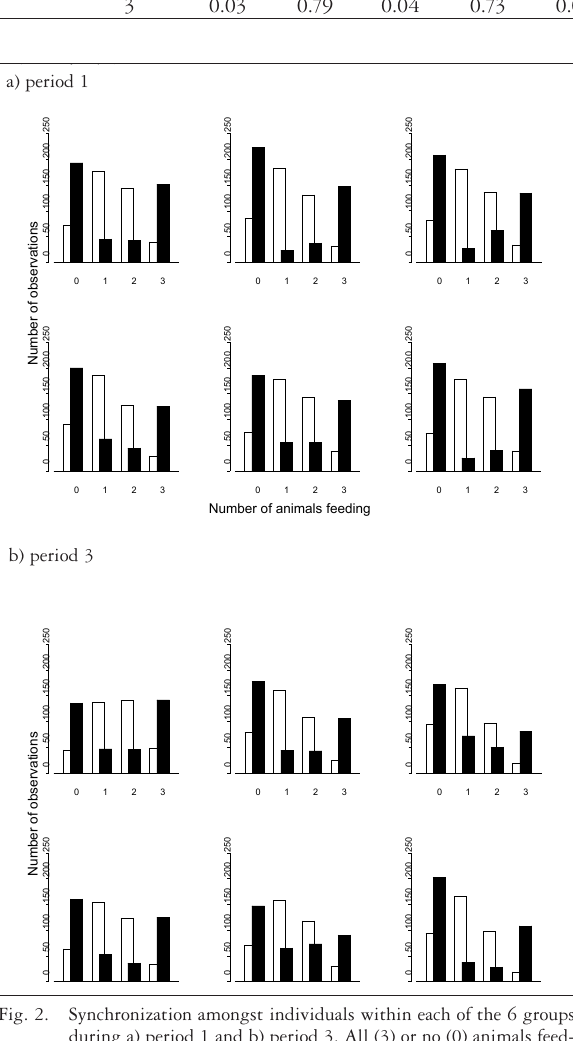
Fig. 2. Synchronization amongst individuals within each of the 6 groups during a) period 1 and b) period 3. All (3) or no (0) animals feed- ing much more often